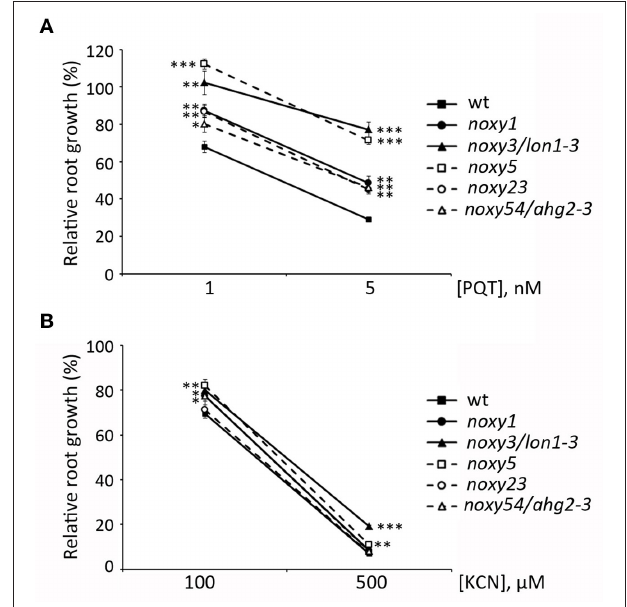
FIGURE 10 | Effect of ROS-generating Paraquat (PQT) and non-ROS-generating KCN on the root growth of noxy mutants. Relative root growth of wild type and noxy1 , noxy3/lon1-3 , noxy5 , noxy23 , and noxy54/ahg2-3 plants in Paraquat (A) and KCN (B) . Asterisks indicate significant differences with wild type plants in each condition ( n ≥ 8, Student’s t -test, *** P < 0.001, ** P < 0.01, * P <